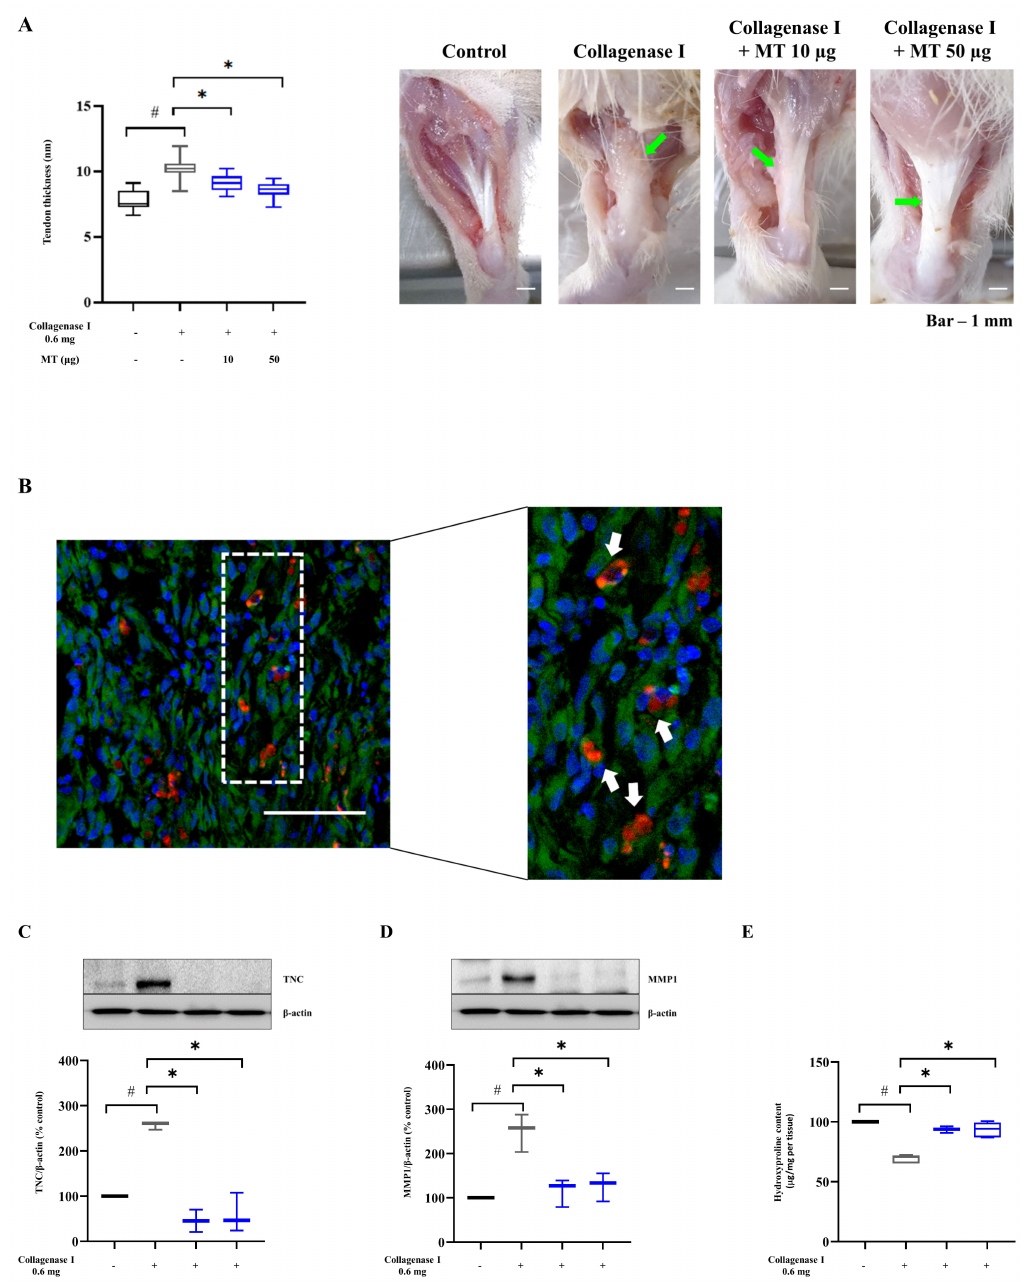
Figure 4. Exogenous mitochondria incorporated into Achilles tendon reduce tendon swelling and elevated TNC/MMP1 level, enhancing collagen production in the collagenase-induced tendinopathy model. Mitochondria (10 and 50 µ g) were locally injected into Achilles tendons at 2 weeks after collagenase-induced injury. ( A ) Changes in hindlimb thickness and tendon tissue gross appearance before and after mitochondrial injection; ( B ) confocal imaging of tendon tissue after mitochondrial injection: red and green colors indicate exogenous mitochondria from L6 rat myoblast (MitoTracker CMSR OS red, white arrows) and endogenous mitochondria of harvested tendon tissue (MitoTracker Green), respectively, at 2 weeks after collagenase injection with DAPI nuclear staining (blue) (scale bar, 400 µ m); representative western blots and densitometric quantification of ( C ) TNC and ( D ) MMP1 ( β -actin as loading control); ( E ) hydroxyproline assay for COL1 data represent mean ± standard deviation (SD) ( n = 3). # p < 0.05 between collagenase (+) group (black) and collagenase ( − ) group as control (white), * p < 0.05 between MT (+) group damaged by collagenase (gray) and MT ( − ) group damaged by collagenase (black). MT, mitochondria; TNC, Tenascin C; MMP1, matrix metalloproteinase 1; COL,